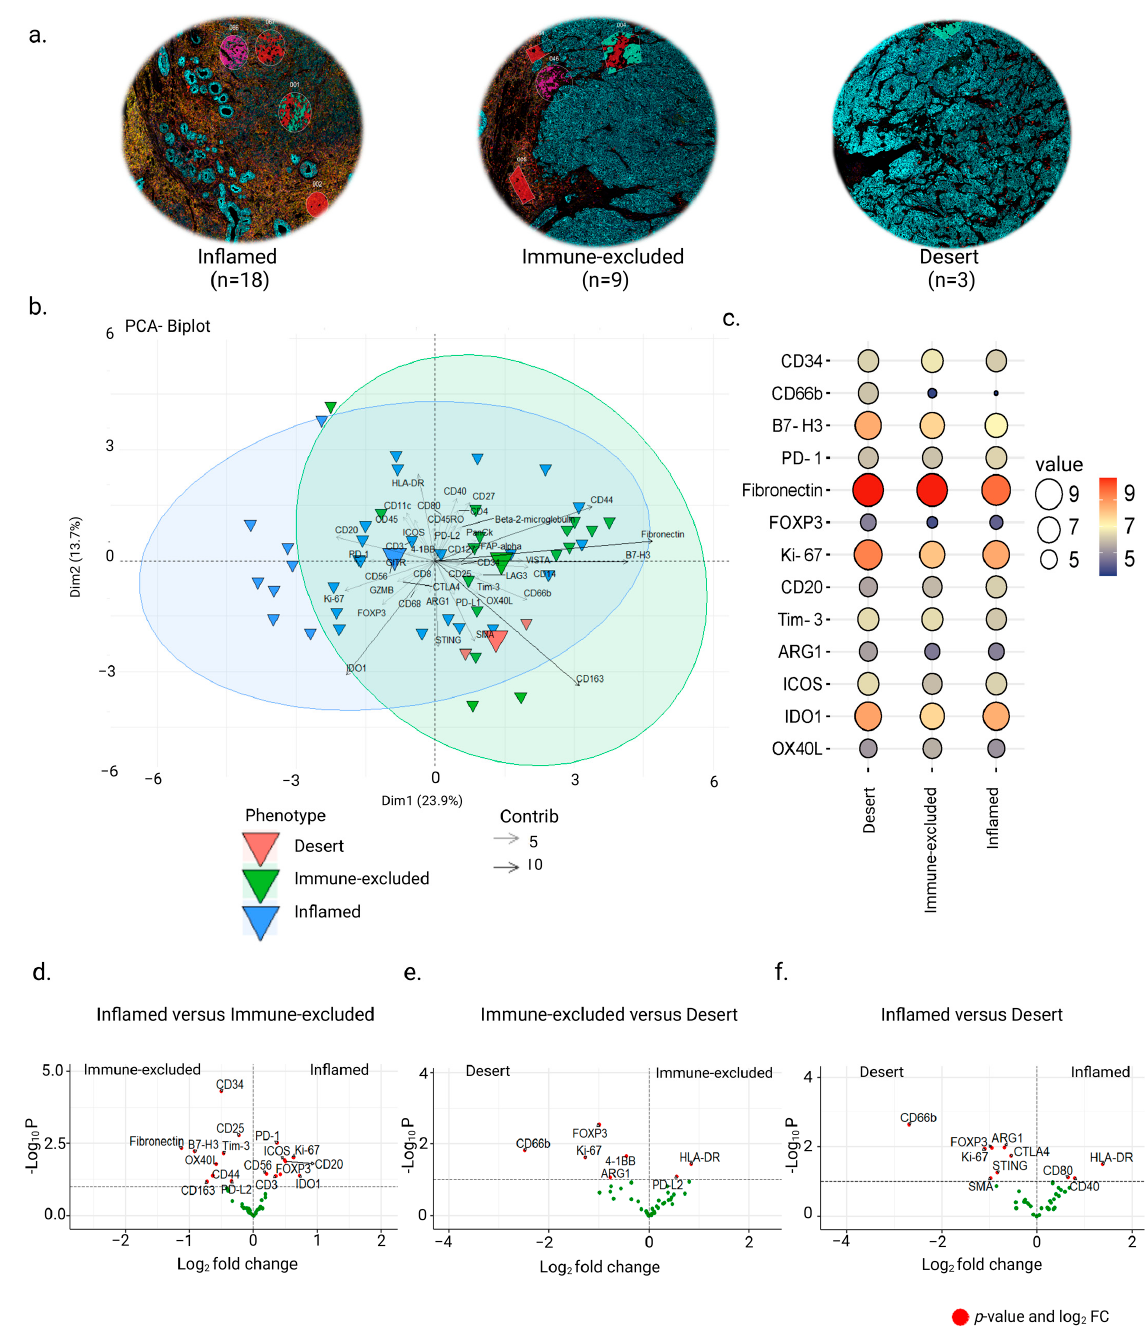
Figure 2. Protein expression in ‘surrounding stromal leukocyte‘ regions associated with immune phenotypes of NPC. ( a ) Representative biopsy sections from the TMA demonstrating the three phenotypes: ‘inflamed’, ‘immune excluded’, and ‘desert’. ( b ) Principal component analysis showing the distribution of the AOIs associated with the three phenotypes. ( c ) Balloon plot showing the top DE proteins between the phenotypes (Kruskal–Wallis test, p -value < 0.05). ( d – f ) Volcano plots showing differences between the ’surrounding stromal leukocyte’ regions of ‘inflamed’, ‘immune-excluded’, and ‘desert’ phenotypes (Mann–Whitney test, p -value <